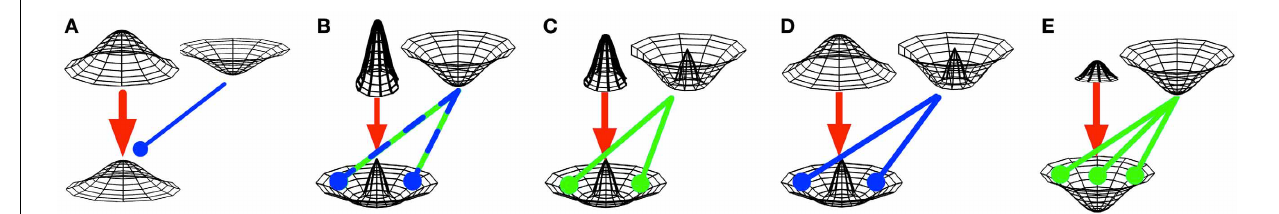
FIGURE 4 | Hypotheses on interactions between pathway outputs. Three-dimensional Gaussians depict neuronal activities (z-axis), as elicited by basal-ganglia pathways, for “central” and “surrounding” cortical representations (x- and y-axes). Direct-pathway effects are denoted by red arrows, while the effects of hyperdirect and indirect pathways are denoted by green and blue arrows, respectively. Pointed arrows denote excitatory, rounded arrows inhibitory effects. (A) Push-and-pull opposition: direct and short indirect pathways may oppose each other in a push-and-pull manner, where the effects of direct and short indirect pathways are equal in spatial extent (e.g., Brown et al., 2004; Frank, 2005; Schroll et al., 2013). In the example shown here, the direct pathway (thick red arrow) overpowers the short indirect pathway (thin blue arrow). (B) Center-surround cooperation. The direct pathway activates specific cortical representations, while either the hyperdirect pathway (Nambu, 2004) or the long indirect pathway (Mink, 1996) globally inhibit these representations. Since the direct pathway’s effect is assumed to be more powerful, center-surround activation